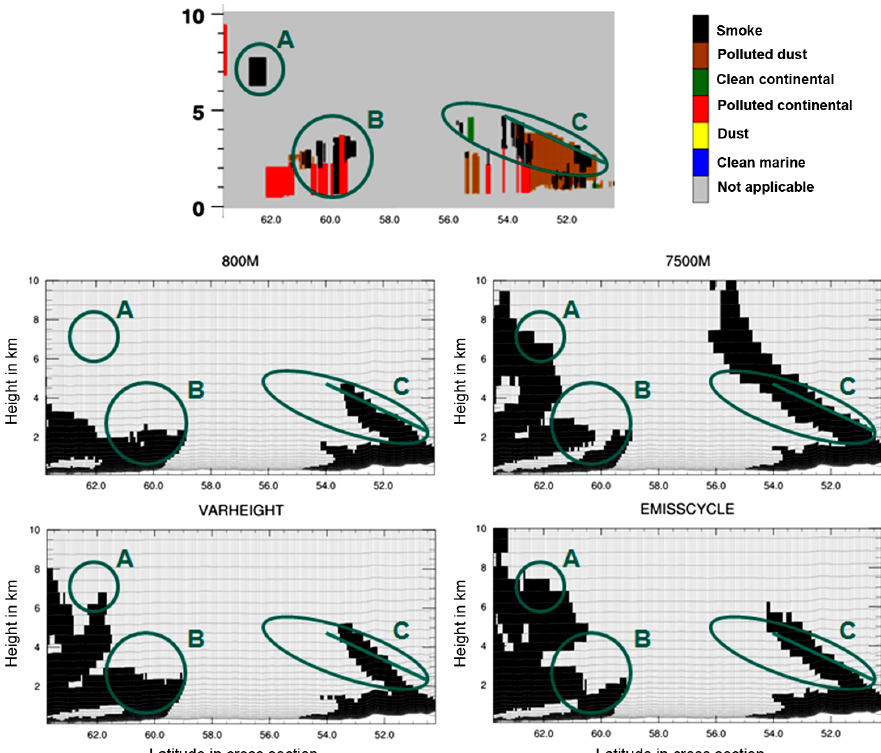
Figure 9. Cross section of aerosol subtypes of CALIPSO overpass at around 09:20UTC, 16 July 2010 (a) . The black color coding de- notes the presence of smoke; brown, green, and red represents polluted dust, clean continental, and polluted continental, respectively. Cross section along the same CALIPSO track for simulations 800M (b) , 7500M (c) , VARHEIGHT (d) and EMISSCYCLE (e) ; here only soot concentrations greater than 0 . 01µgm − 3 are